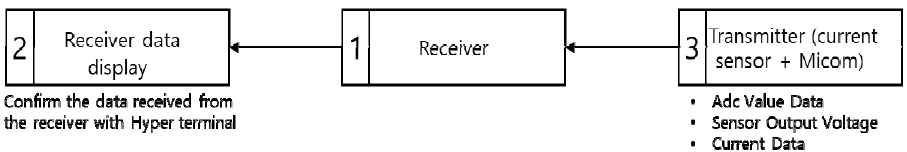
Figure 13. Flowchart of the monitoring system.